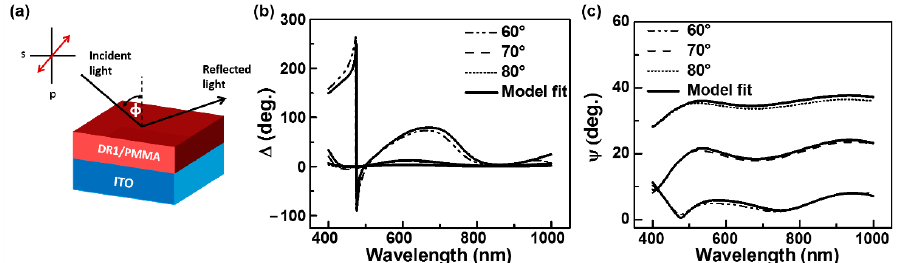
Figure 4. ( a ) Schematic of light reflection on a layered stack (i.e., polymer film on top of an ITO layer), which we used in our SE experiments. The experimental data, measured at three different angles (i.e., 60°, 70°, and 80° incidence angles) are ( b ) delta ( Δ ) angle and ( c ) psi ( 𝜓 ). Experiments were performed on DR1/PMMA thin films (thickness ~ 58 nm) at 8%, 10%, and 12% w / w concentrations (only the data of 8% w / w are shown). Dotted curves are experimental data and the theoretical fits are represented by full curves. See text for more details.